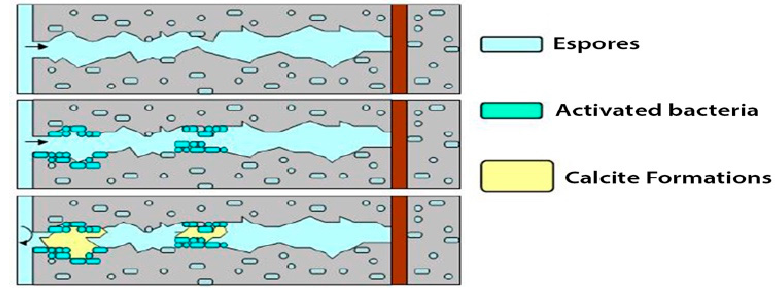
Figure 2. Bacteria Based Crack Repair Mechanism